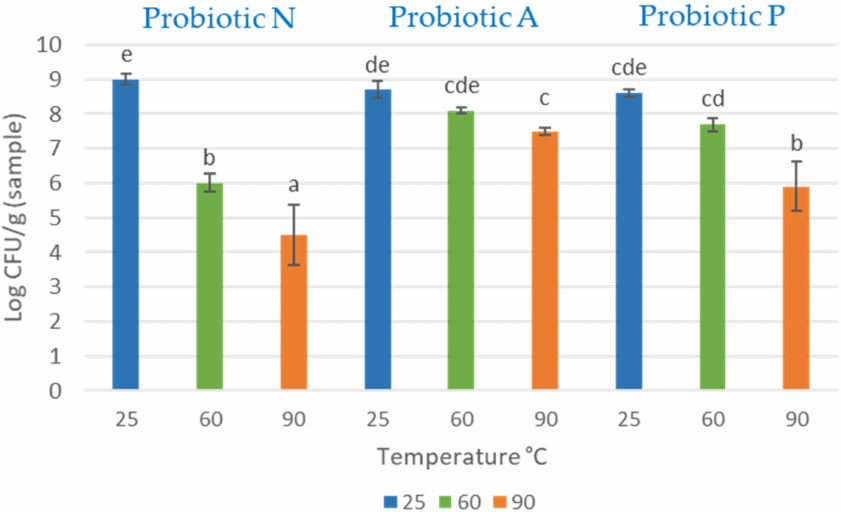
Figure 1. Microbiological analysis. Log CFU/g of probiotic samples probiotic N, probiotic A, and Probiotic P, prepared at three different temperatures T1 (25 ◦ C), T2 (60 ◦ C), and T3 (90 ◦ C). Letter (a–e) represent significantly different groups ( p ≤ 0.05), based on ANOVA and the Tukey HSD post hoc